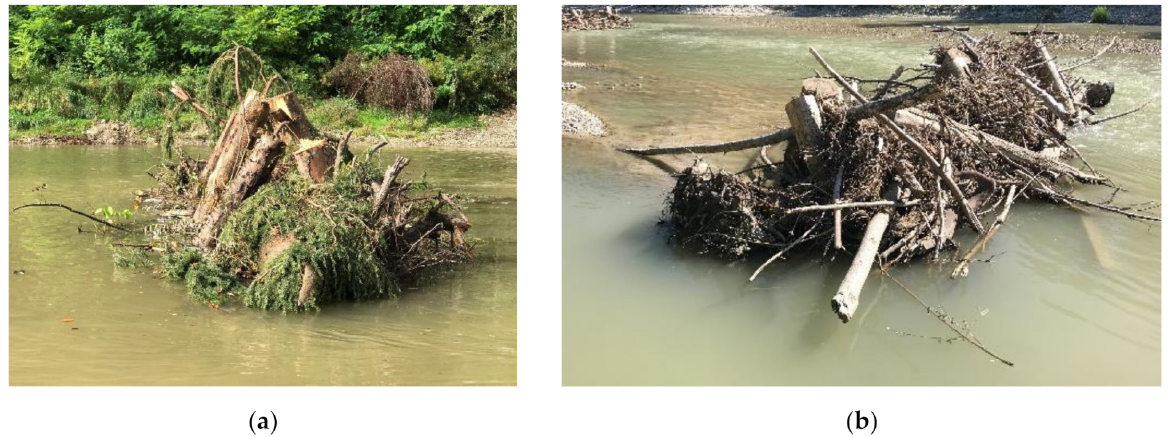
Figure 10. ( a ) LWS islet right after completion; Emme River; Photo: M. Mende. ( b ) Evolution of a LWS islet approx. 6 months after completion; Emme River; Photo: M. Mende.